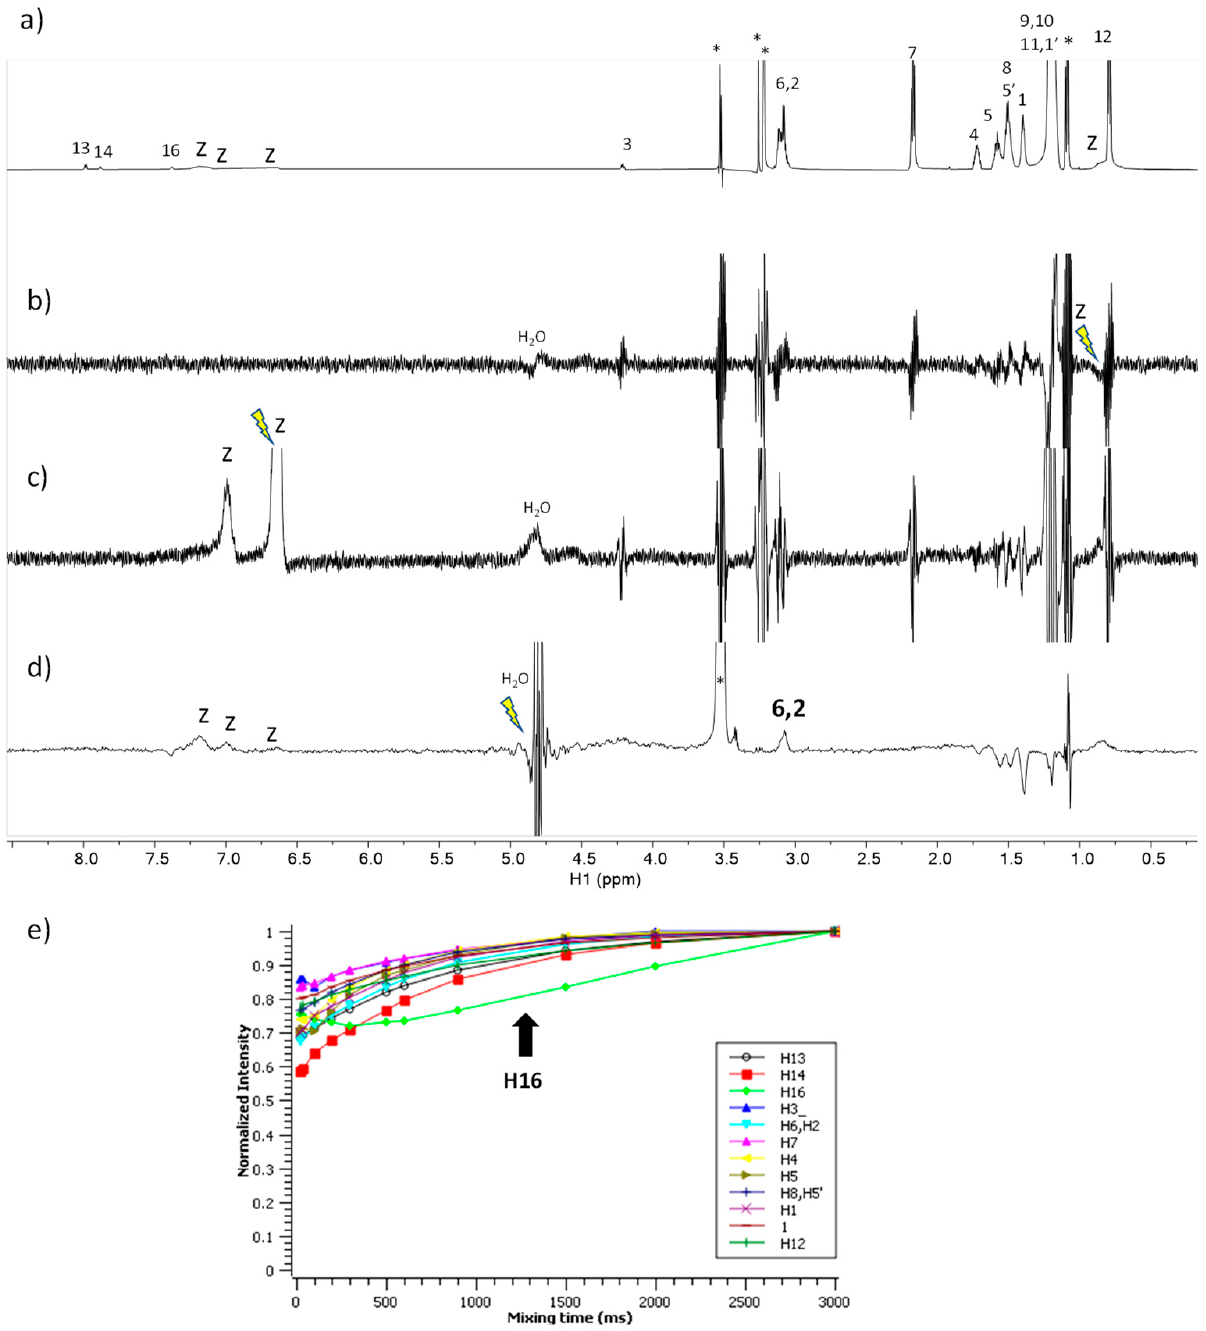
Figure 8. NMR binding interaction study between surfactant C 9 (LA) 2 and zein. ( a ) 1 H NMR ( b , c ) STD off-on with on-saturation applied over the signal of zein at ( b ) 0.82 ppm and ( c ) at 6.5 ppm ( d ) waterLOGSY spectrum with mixing time 500 ms. In ( b – d ) the signal selectively saturated or inverted is indicated with a ray symbol and the assignment of the relevant responses is indicated. Some impurities are denoted with asterisks. The letter z refers to zein signals. ( e ) Plot of the normalized signal intensity of the surfactant protons as a function of mixing time of the NOE-exch spectra.